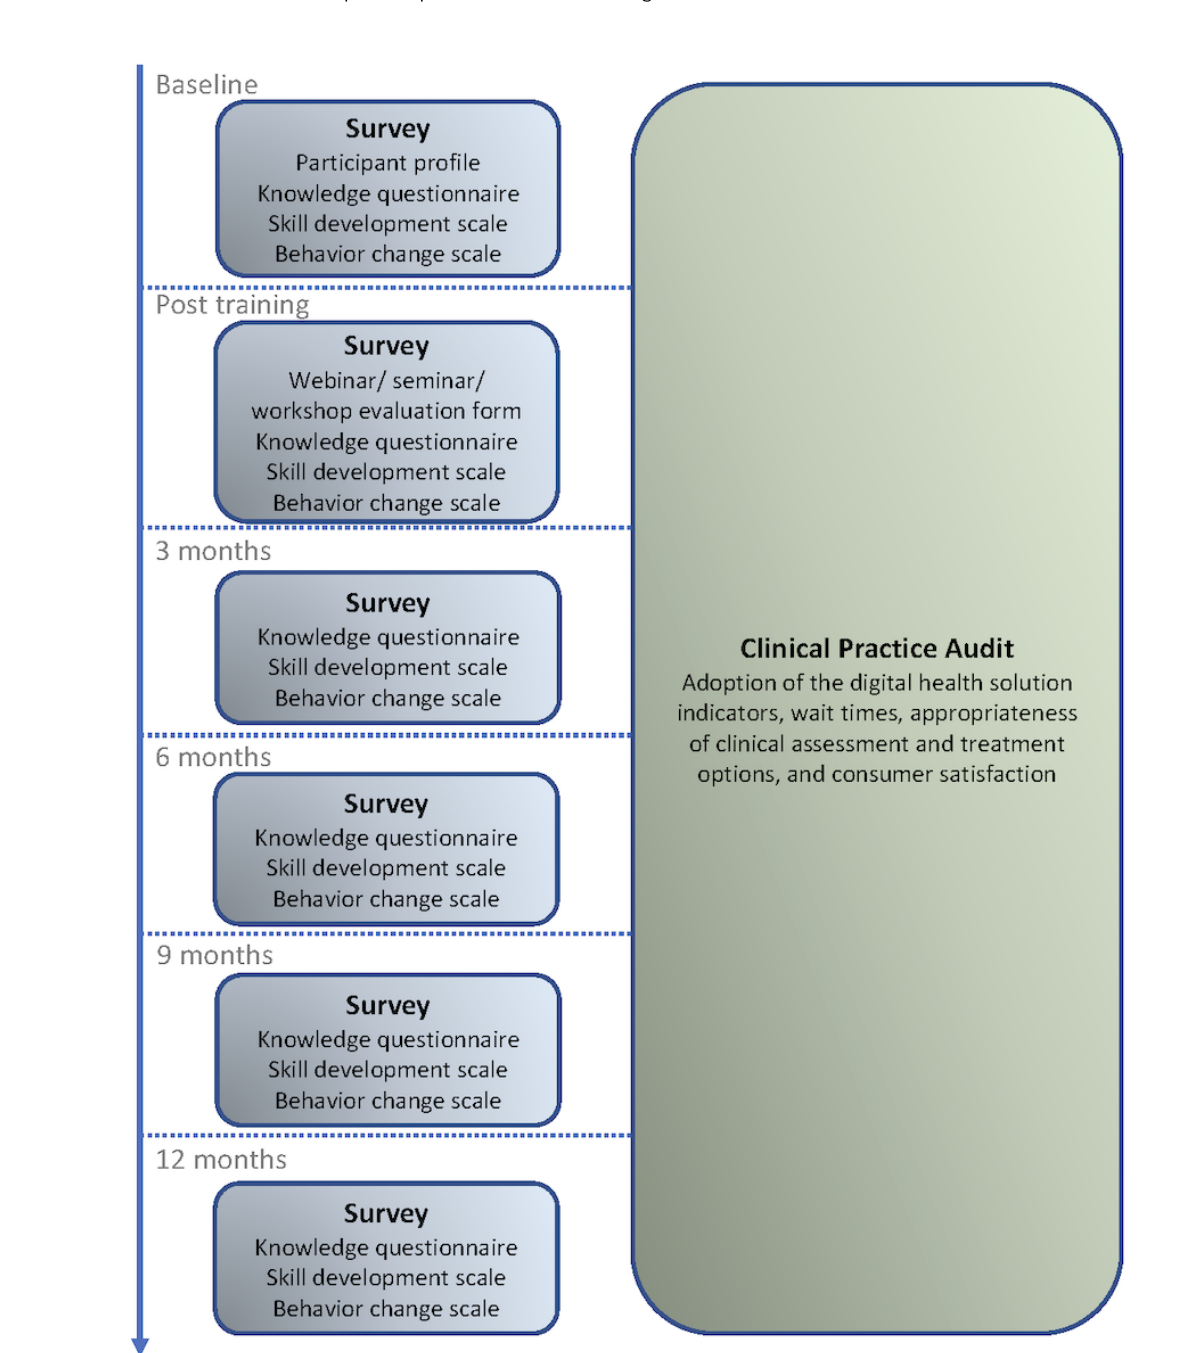
Figure 1. Flow chart of evaluation methods pre- and post-education and